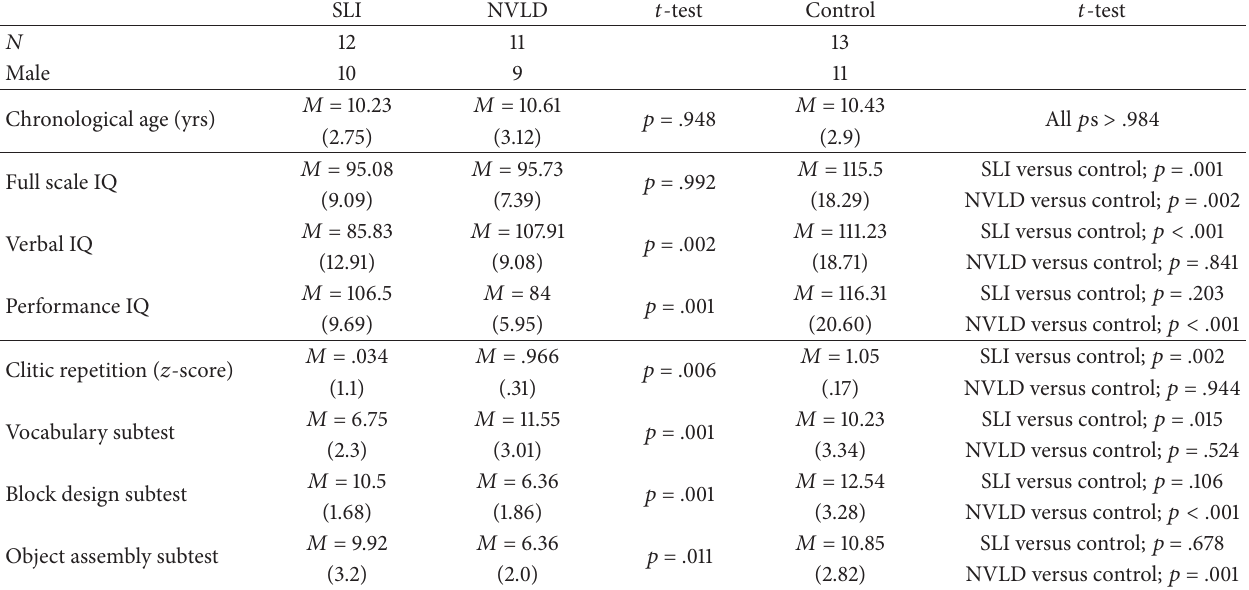
Table 2: Characteristics of participants included in the ERP experiment. Standard deviations in